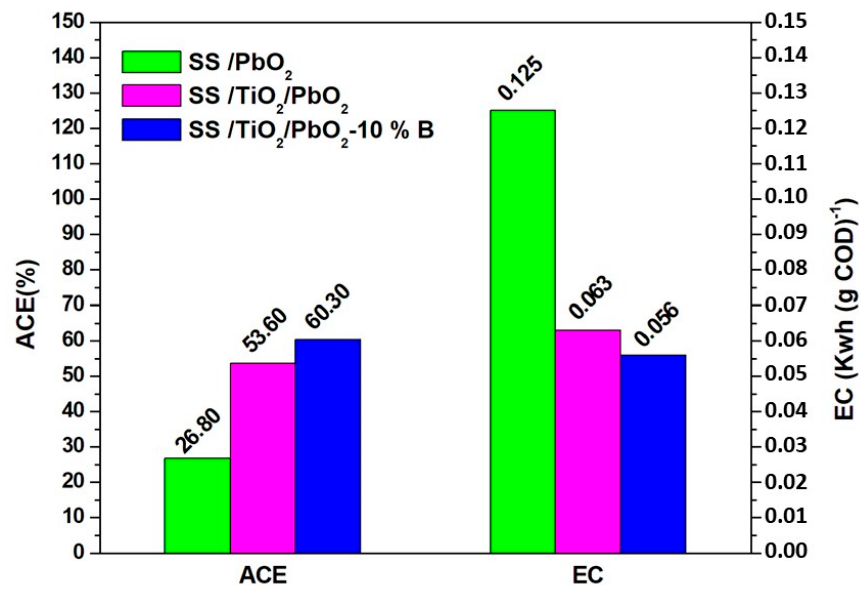
Figure 10. Evaluation of the average current efficiency (ACE) and the energy consumed (EC) at the end of the AMP electrolysis using SS/PbO 2 , SS/TiO 2 /PbO 2 and B-doped SS/TiO 2 /PbO 2 anodes.